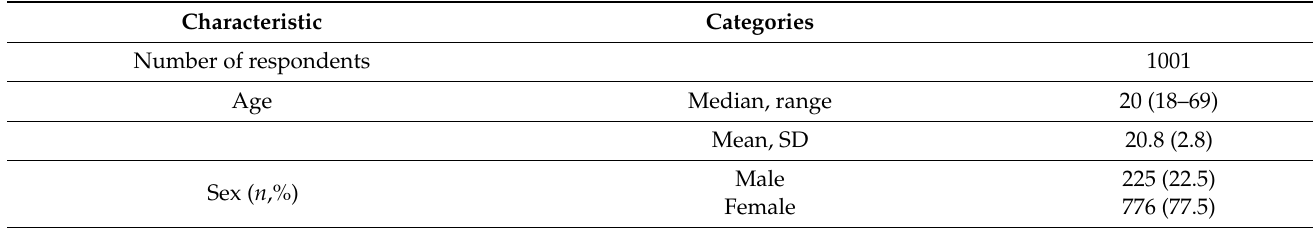
Table 1. General characteristics of the participants in our